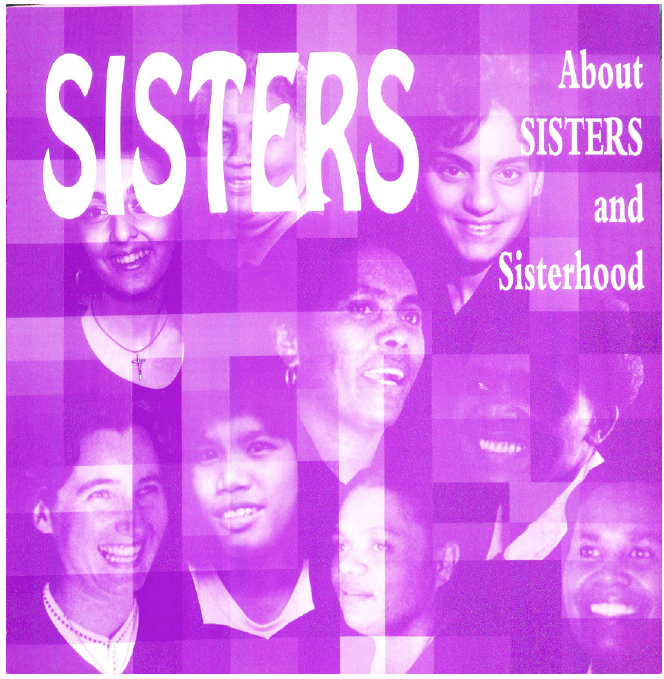
Figure 2: Cover of the official SISTERS flyer. SISTERS box. Image by author, May